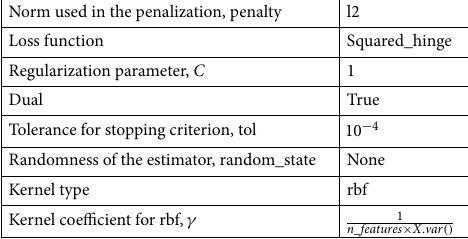
Table 1. Setting parameters for SVM.